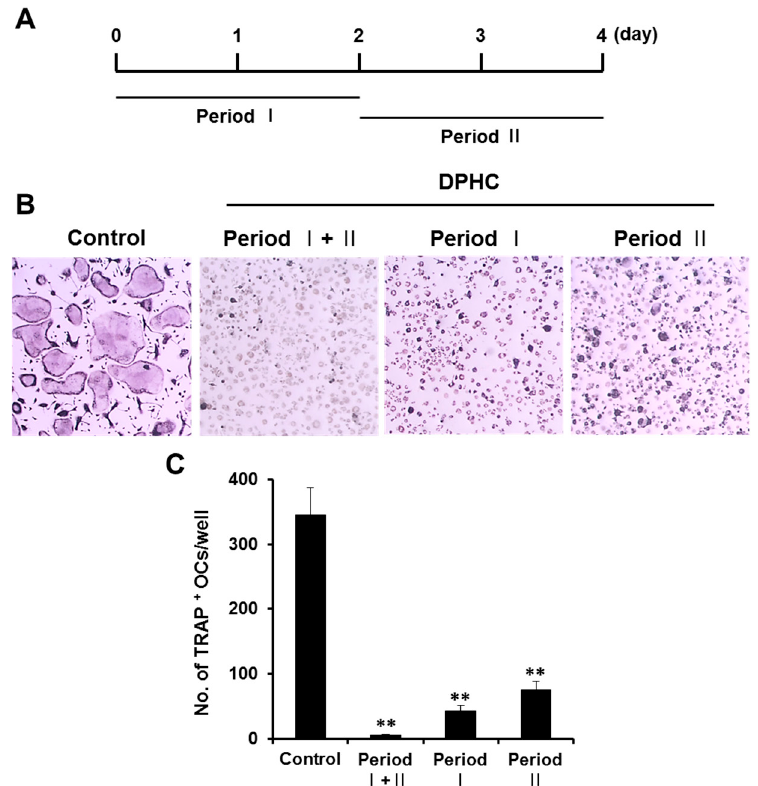
Figure 2. Effects of DPHC on osteoclast formation after exposing BMMs for different time periods to DPHC. ( A ) Schematic representation of the in vitro experiment; ( B ) BMMs were cultured in osteoclastogenic media with DPHC (75 µ g/mL) added during different stages of cell culture. Osteoclast formation was confirmed by TRAP staining; ( C ) TRAP-positive multinucleated cells (MNCs) were counted; ** p < 0.01 versus vehicle-treated control.